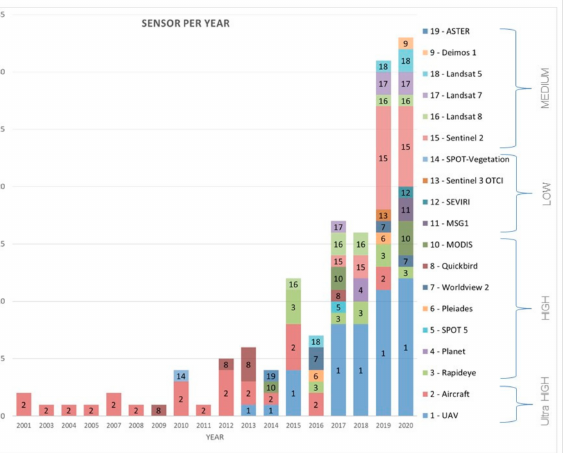
Figure 6. Usage of each platform per year, grouped by resolution (ultra-high, 1–20 cm; high, 0.5–5 m; medium, 10–30 m; low >100